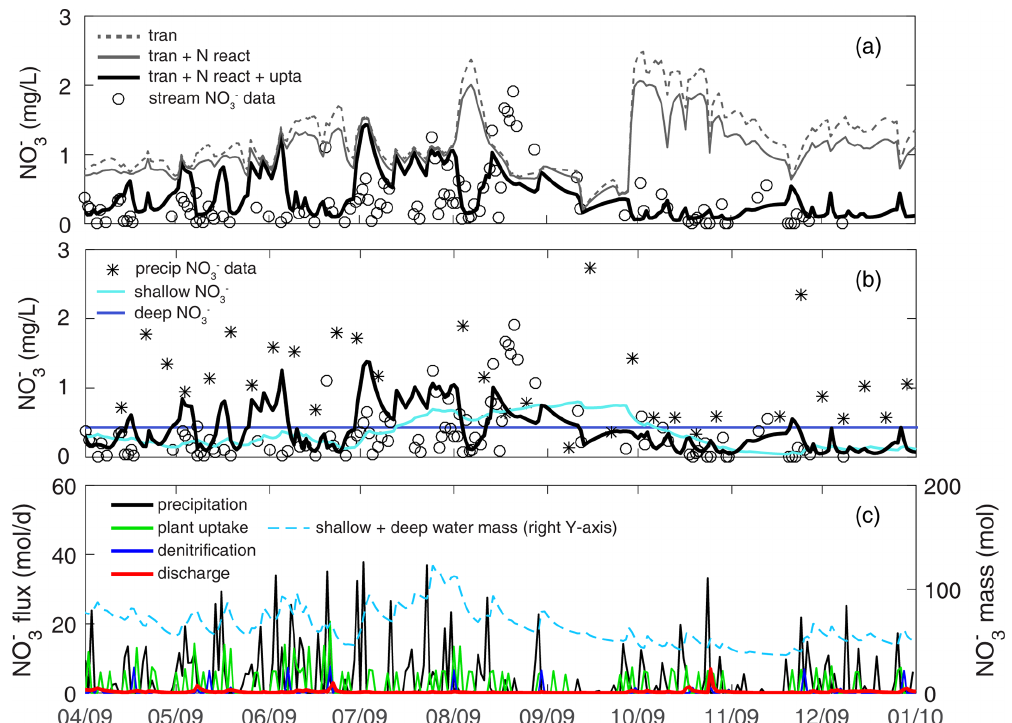
Figure 8. Stream nitrate dynamics and fluxes at Shale Hills in Example 2. (a) Three simulation scenarios with different processes are demon- strated here: transport only (dashed line, tran ), transport + N reaction (gray line, tran + N react), transport + N reaction + plant uptake (thick black line, tran + N react + upta), where N reactions include both nitrate leaching and denitrification (see Fig. 7); (b) nitrate concentration in precipitation and shallow and deep water; (c) nitrate fluxes and budget. Note that nitrate leaching was ignored in (b) due to its minimal flux as N deposition from rainfall was the dominant input (Weitzman and Kaye,